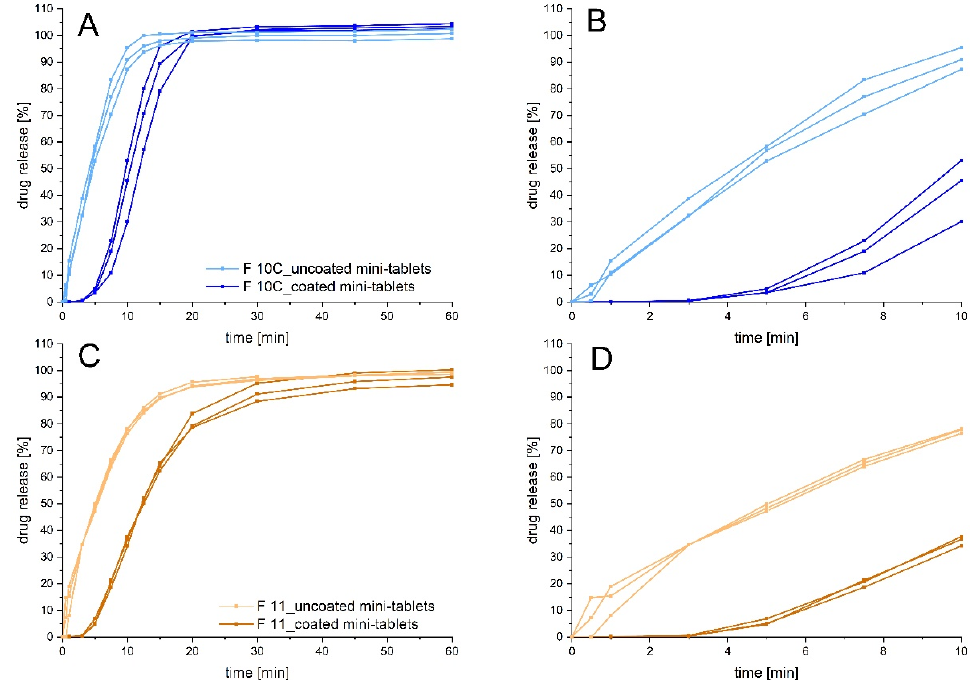
Figure 7. Dissolution profiles of coated and uncoated mini-tablets of F 10C ( A ) and 11 ( C ) and the respective magnification of the profiles in the first minutes ( B , D ); 37 ± 0.5 °C, medium: phosphate buffer pH 6.0; n = 3.